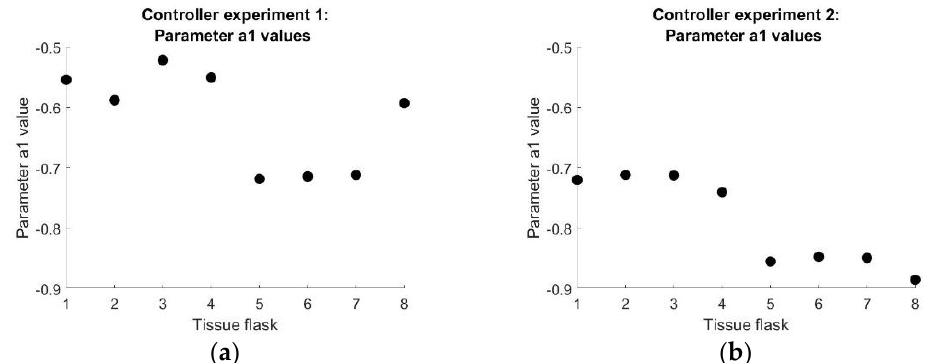
Figure 11. ( a ) The fixed a 1 parameter of the resulting DARX model for all tissue flasks of controller experiment 1. ( b ) The fixed a 1 parameter of the resulting DARX model for all tissue flasks of controller experiment 2.